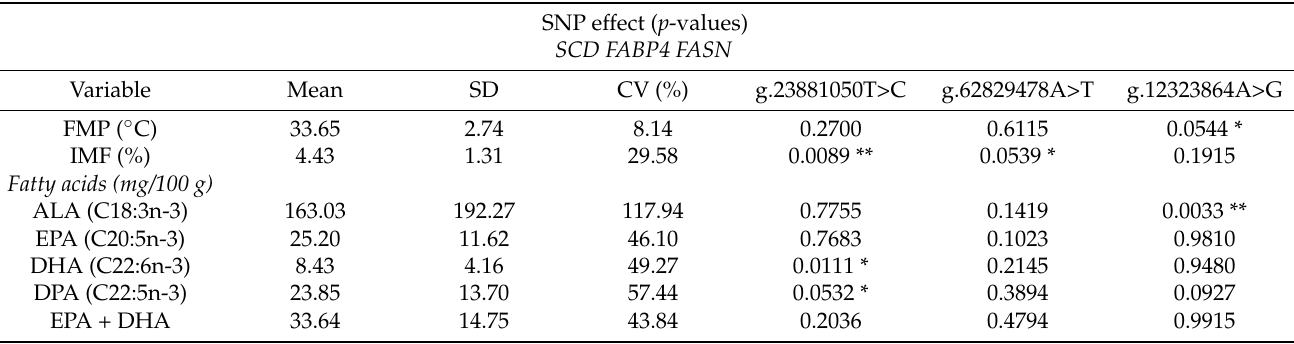
Table 5. Associations between SNP mutations and FMP, IMF, and fatty acids in TAW lambs #